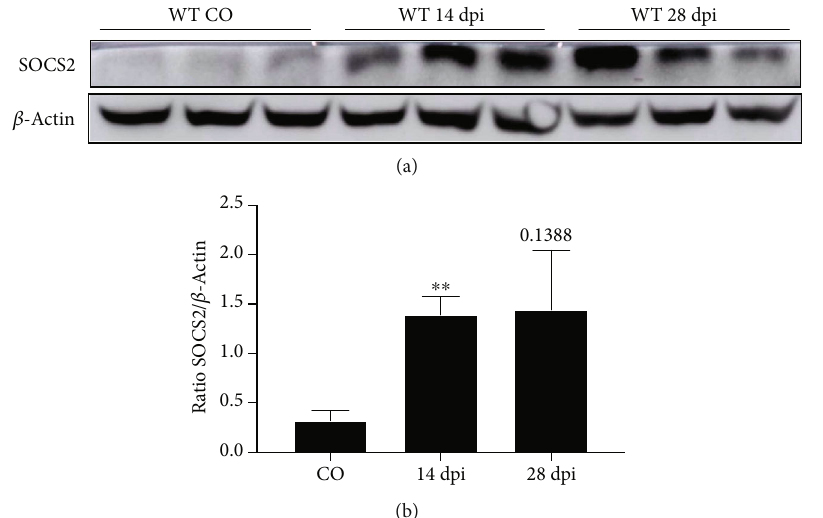
Figure 1: SOCS2 expression during EAE. WT and SOCS2 -/- mice received an injection of MOG and 28 days post injection (dpi), brain samples from WT and SOCS2 -/- mice were harvested and homogenized and Western Blotting analysis was performed using speci fi c antibodies. (a) SOCS2 and β -actin expression. (b) Normalization graphic of the blots for SOCS2 is shown. β - Actin was used for normalization of protein load. Each band represents a di ff erent mouse. Data are representative of three independent experiments and shown as the mean ± SEM . ∗∗ p = 0 : 01